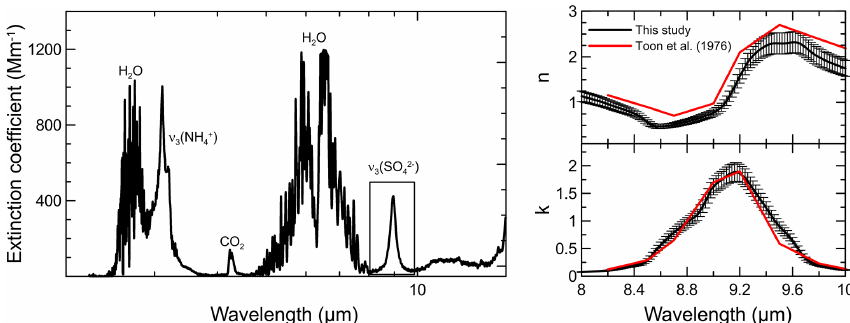
Figure A1. Left panel: long-wave spectrum of ammonium sulfate measured in CESAM in the 2–15µm range. The vibrational modes ν 3 (NH + ) (3230cm − 1 or 3.10µm) and ν 3 (SO − 4 ) (1117cm − 1 or 8.95µm) of ammonium sulfate are identified in the plot. Absorption bands 4 2 attributed to gas-phase water vapor and CO 2 present in the chamber during experiments are also indicated. The rectangle in the plot indicates the spectral region where the retrieval of the complex refractive index was performed. Right panel: real and imaginary parts of the refractive index obtained by optical closure. The results are compared with the ammonium sulfate optical constants from Toon et al.